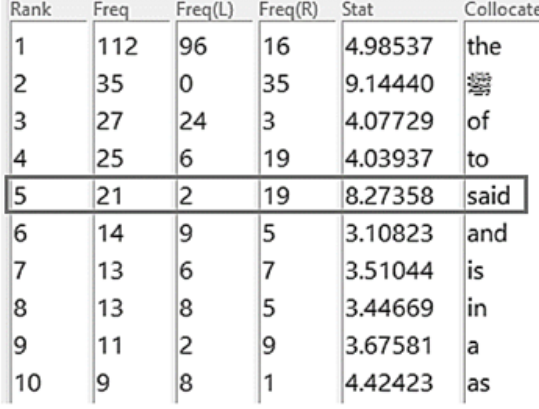
Figure 2. Top 10 collocations of Prophet.